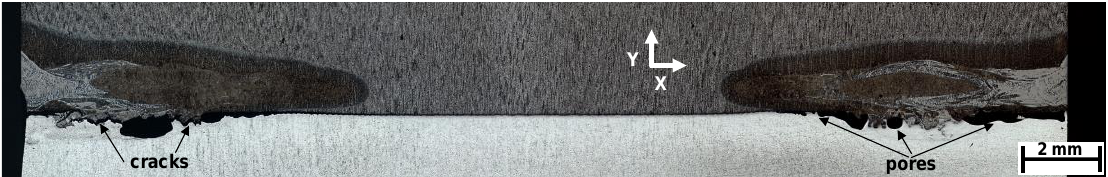
Figure 5. Metallographic cross section of a dissimilar steel-aluminium alloy weld (cracks and pores exemplarily marked).